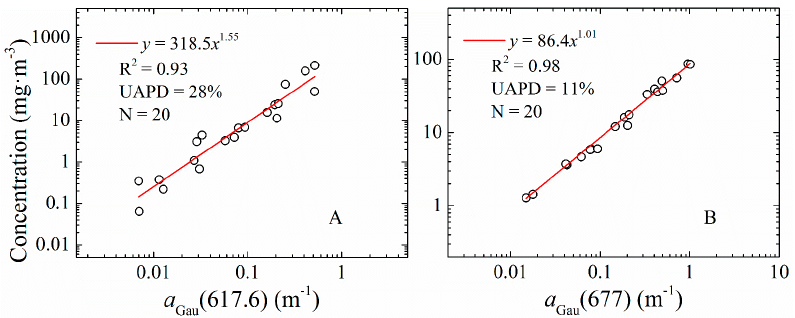
Figure 7. Co-variation between the measured: phycocyanin ( A ); and chlorophyll a ( B ) concentrations, and the Gaussian peak heights ( a Gau ( λ )) centered at 677 and 617.6 nm; and the corresponding relationship, R-square the mean UAPD, and the sample number (N).